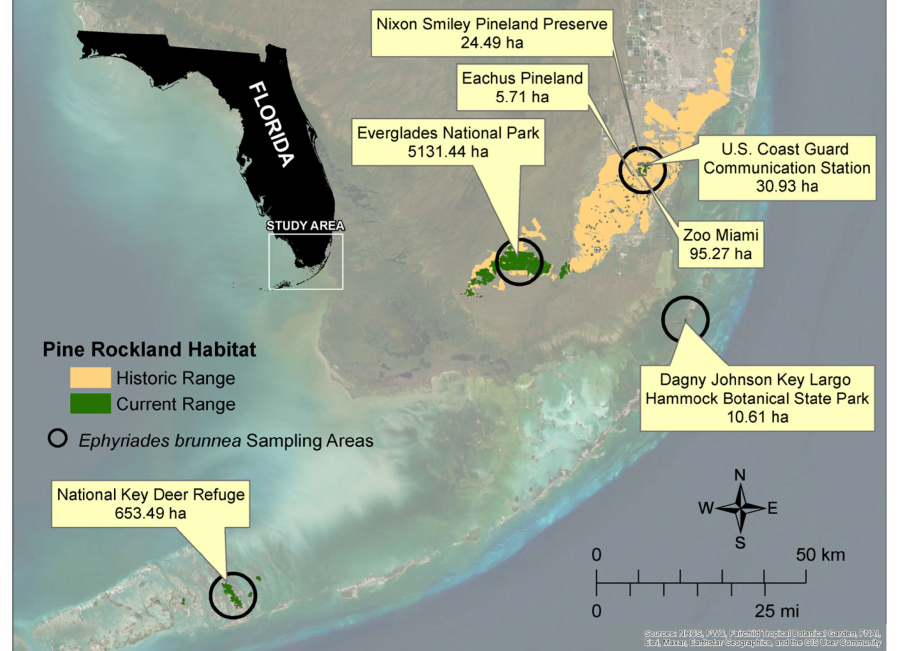
Figure 2. Map showing historic and current range of pine rockland habitat in South Florida along with E. b. floridensis conservation property sampling areas extending from the Lower Florida Keys north to Miami-Dade County. Properties where E. b. floridensis samples were taken are noted, as well as the current size of pine rockland habitat within that property. Areas were calculated using Florida Cooperative Land Cover Map developed by FWC and FNAI (version 3.6).